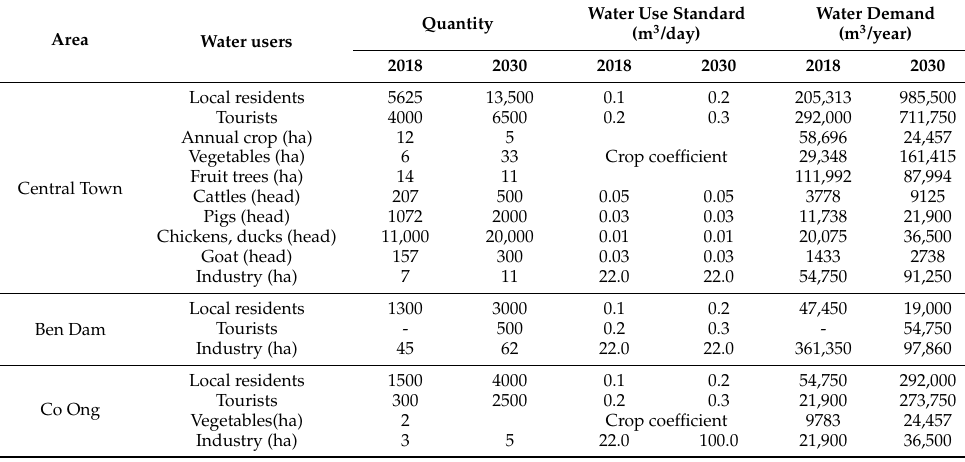
Table A1. Water demand in Con Dao (Con Dao Statistical Yearbook 2018).